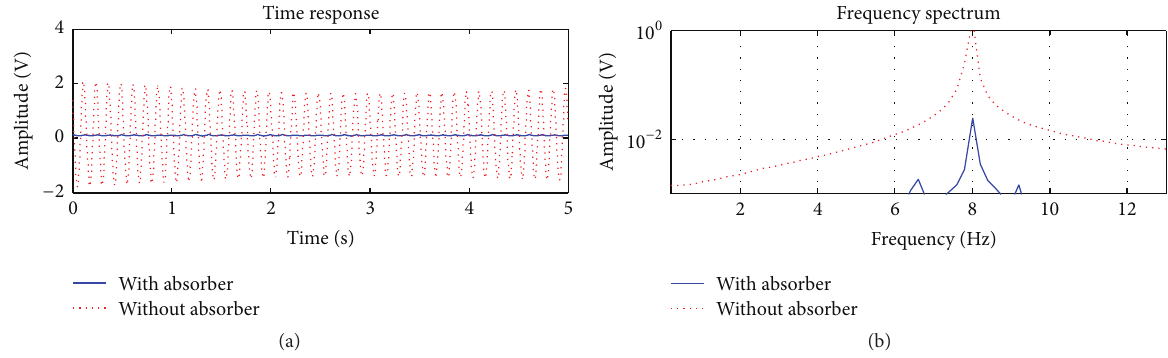
Figure 10: Experiments with and without absorber when the unbalanced rotor runs at 480